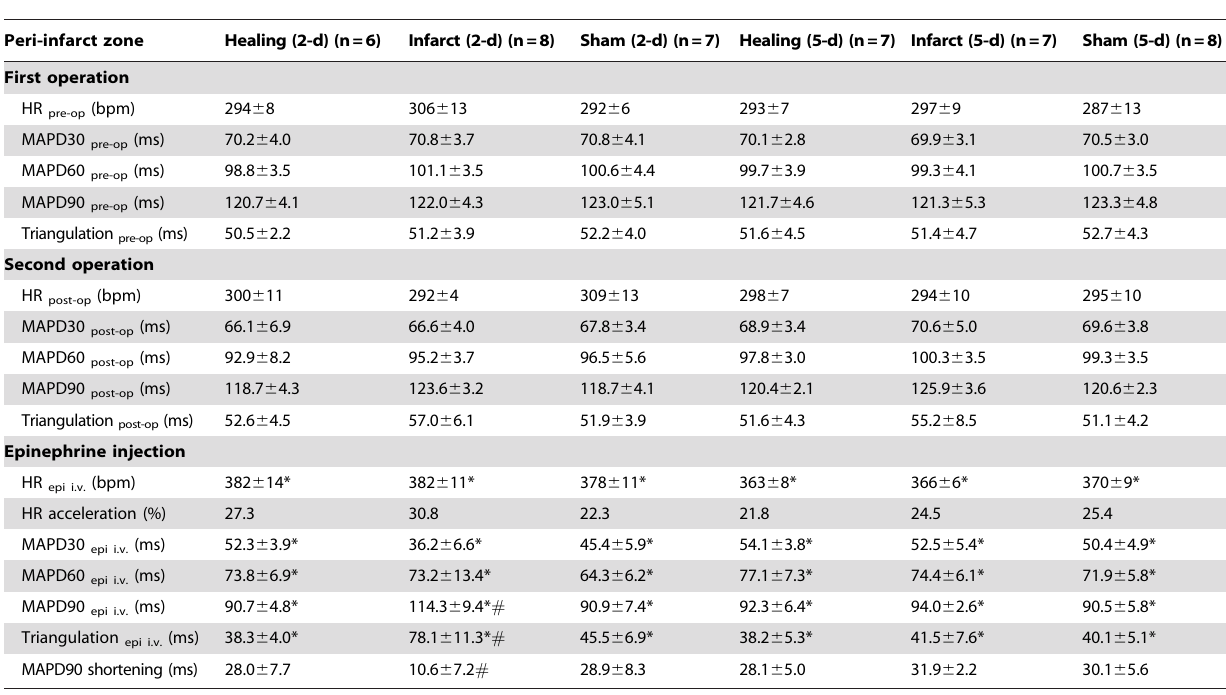
Table 3. Comparison of MAP data recorded at the peri-infarct zone and heart rate (HR) in animals subjected to ischemia and healing, infarction, or sham